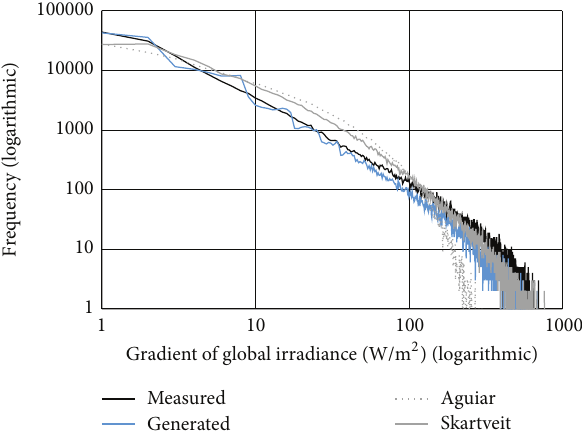
Figure 6: Frequency of gradients of the global irradiance in Lindenberg, Germany (2005). The model quality in lower gradient ranges of up to 10 W/m 2 is similar in all models. In the range of 10 to 100W/m 2 , significant deviations can be detected for the models of Aguiar and Skartveit (grey), whereas the new method (blue) shows good congruence. For gradient values of more than 100 W/m 2 , the model of Aguiar underestimates the frequency significantly, while the new method and the method of Skartveit feature similar frequency values compared to the measurement data (black).